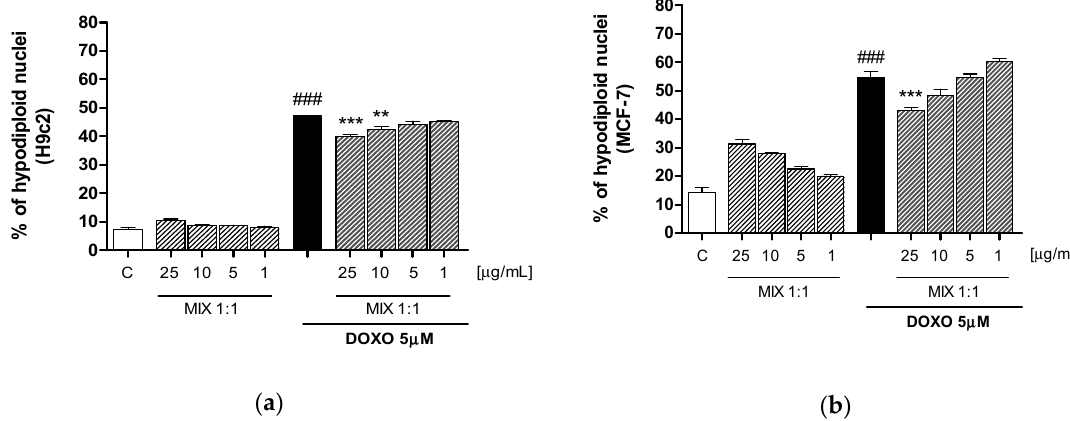
Figure 5. Apoptosis detection by propidium iodide (PI) staining of hypodiploid nuclei after H9c2 ( a ) and MCF-7 ( b ) incubation with MIX 1:1 ratio (1–25 μ g/mL), alone and in combination with DOXO (5 μ M) for 24 h. Data are expressed as mean ± s.e.m. of % of hypodiploid nuclei. *** and ** denote respectively p < 0.001 and p < 0.01 vs DOXO; ### denotes p < 0.001 vs C.